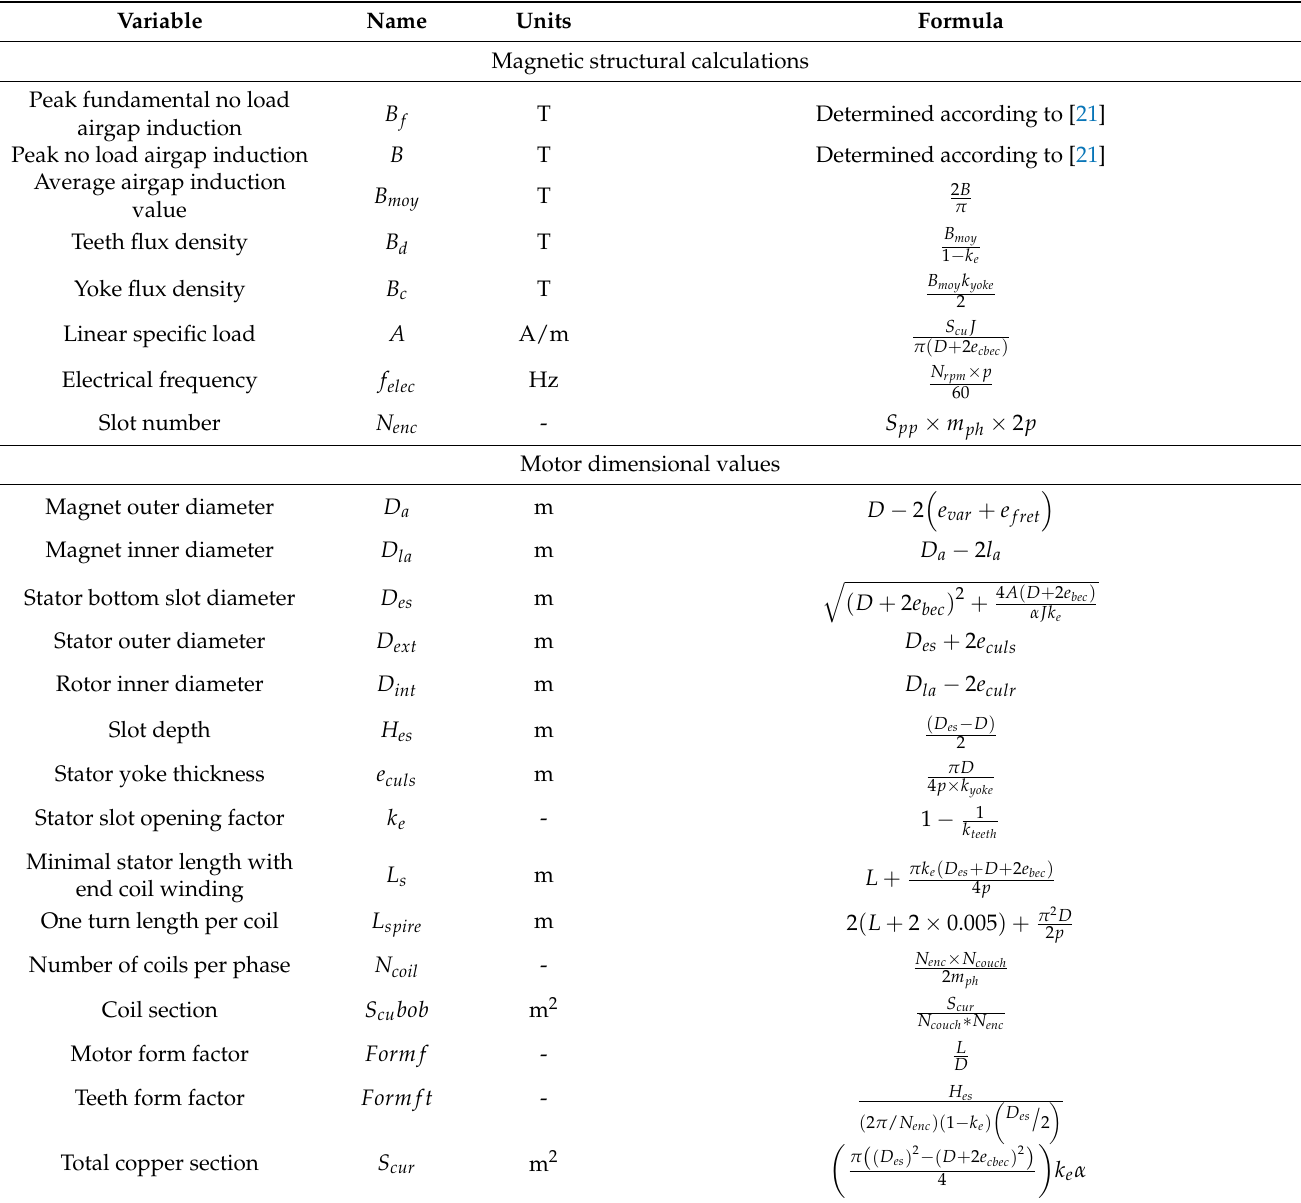
Table 1. Equations that complete the analytical